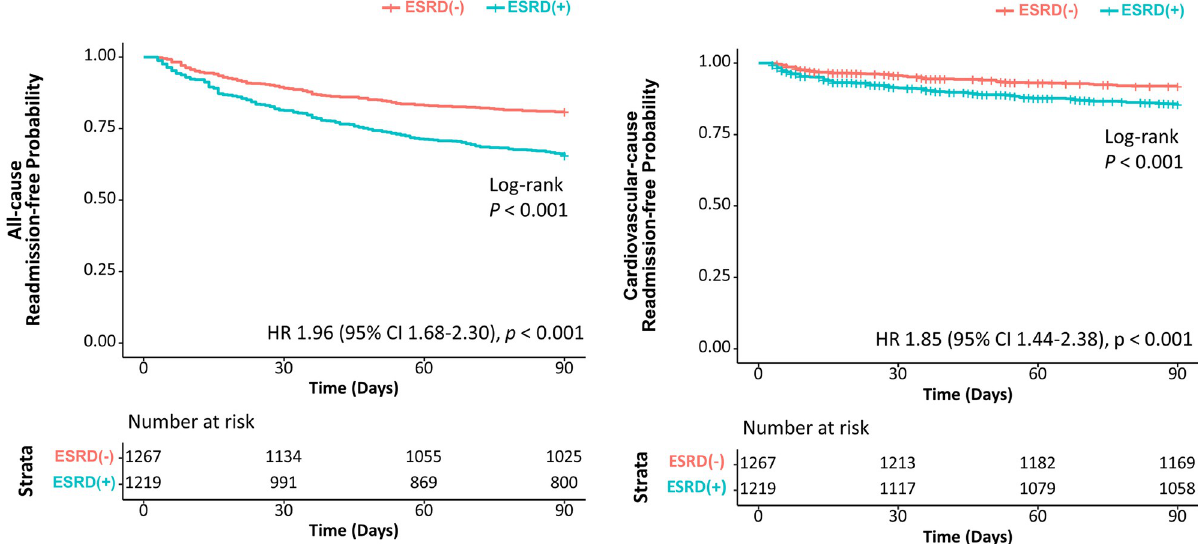
Fig 3. Kaplan-Meier curves of all-cause and cardiovascular readmissions after TAVR in patients with and without ESRD. Kaplan-Meier curve on the left shows the probability of being readmission-free for any cause in patients with and without ESRD over 90 days after discharge from the index hospitalization. Similarly, the Kaplan-Meier curve on the right shows the probability of being readmission-free for cardiovascular cause.